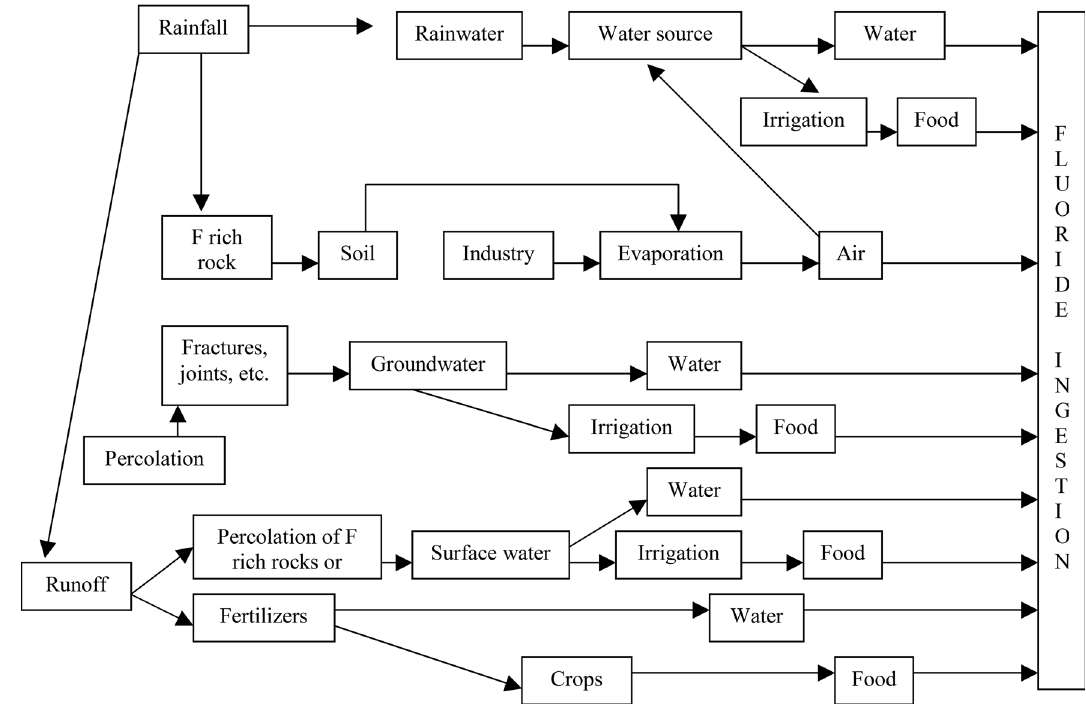
Fig. 4 Probable transmission routes of fluoride ingestion